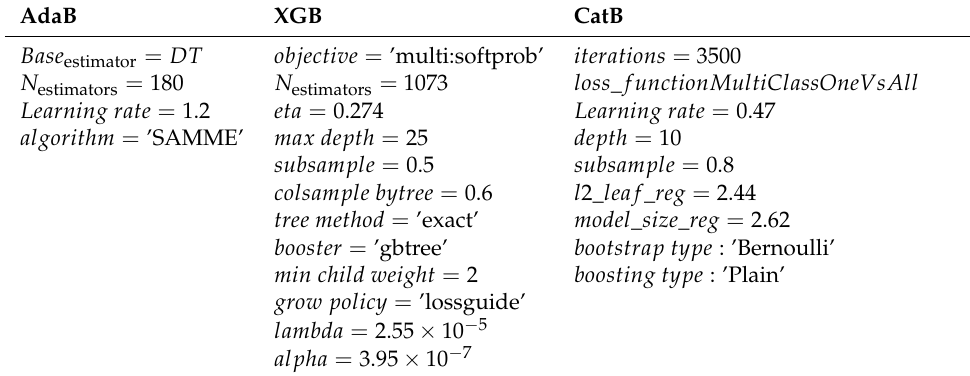
Table 2. Hyperparameters for boosting